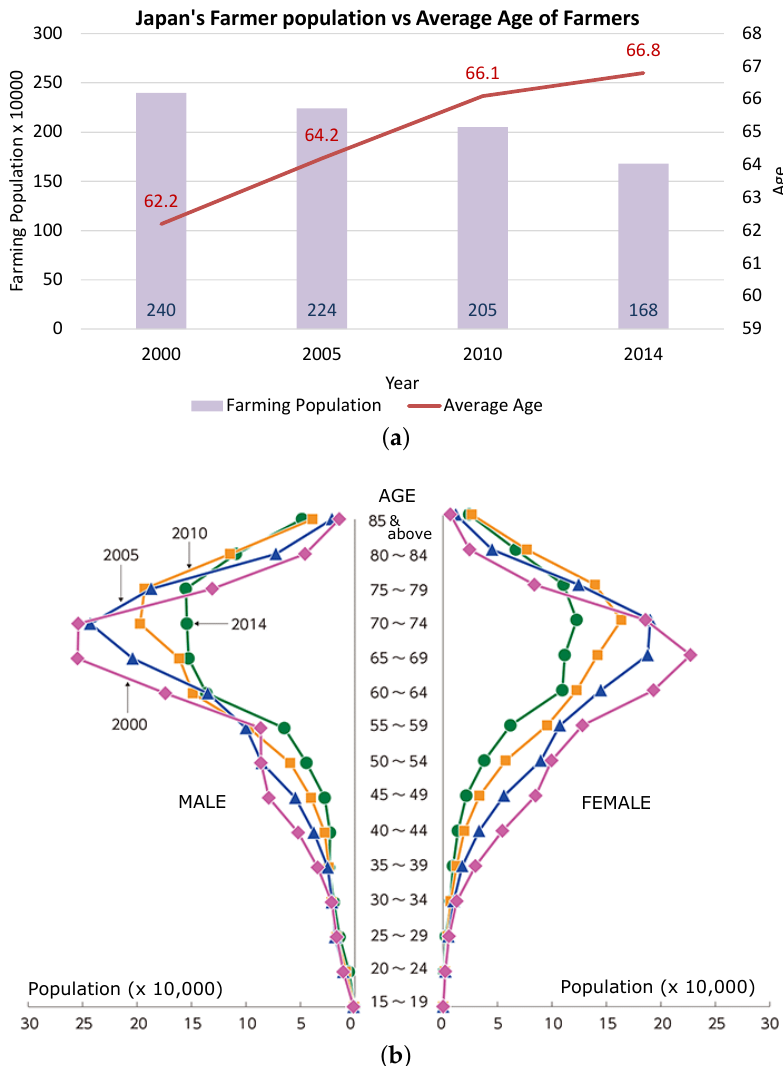
Figure 1. ( a ) Population and average age of farmers in Japan. Data from Japan’s Ministry of Agriculture, Forestry and Fisheries (MAFF) [1]. ( b ) Census of agriculture in Japan